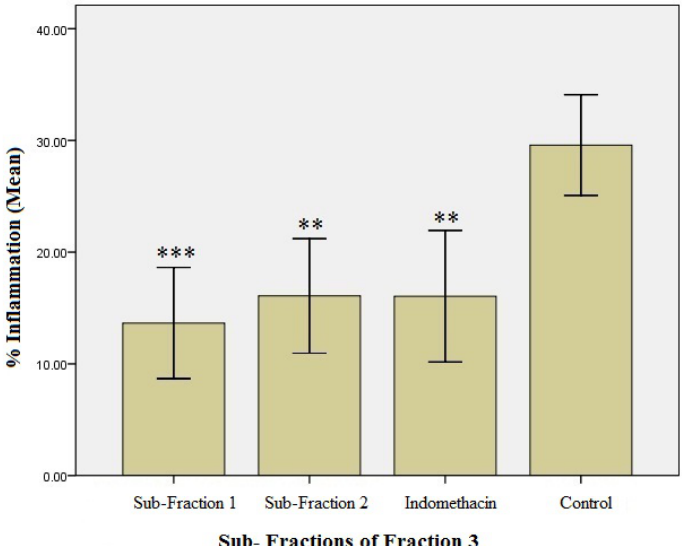
3rd h of carrageenan administration (n =